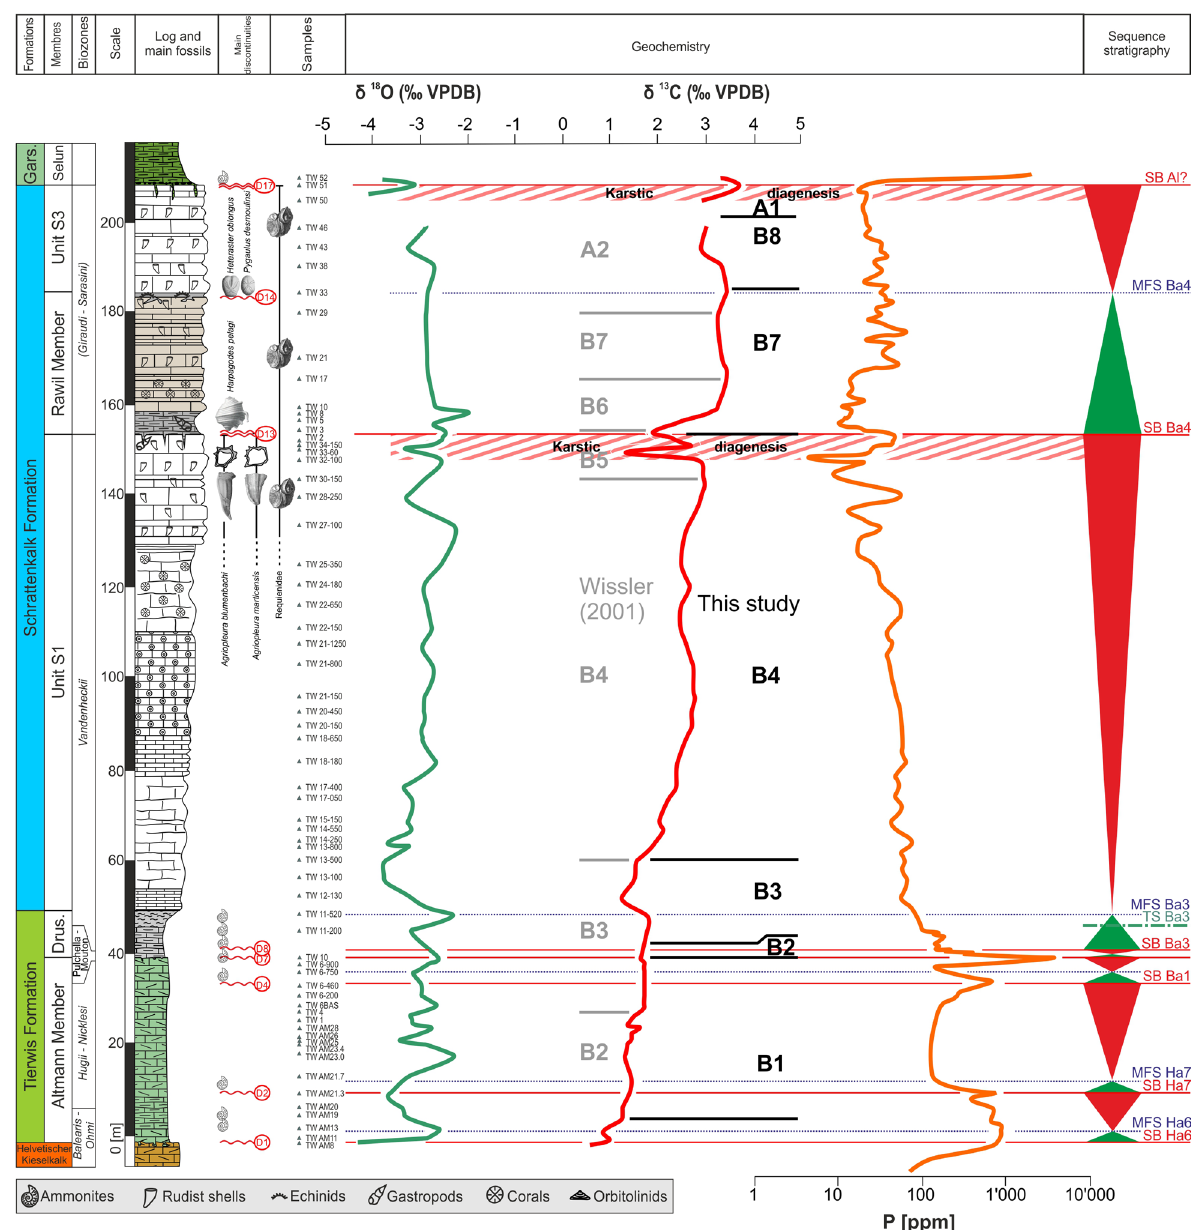
Fig. 8 Tierwis-Grauchopf section. Lithological log modified after Wissler (2001) with main fossil-bearing levels and stratigraphical extension of rudist species/families, discontinuity surfaces (D1 to D17), geochemical analyses and sequence stratigraphic interpretations. Samples’ positions are form Bodin et al. (2006b), Bonvallet (2015), Bonvallet et al. (2019) and Godet et al. (2013) and correspond to the phosphorus (orange line) curve from Bonvallet et al. (2019). The carbon and oxygen isotope curves (red and green lines) are form Wissler (2001). Isotopic segments B1 to A2 reported on the δ13C curve are labelled after the nomenclature of Wissler (2001), and Wissler et al., (2002, 2003). Rudist-shells drawings from Matheron (1842) and from Pictet and Campiches (1868–1871). Rudist-cross sections modified after Masse and Fernerci-Masse (2015). Harpagodes drawing from Pictet and Renevier (1854–1858). Echinoids drawings from Pictet and Renevier